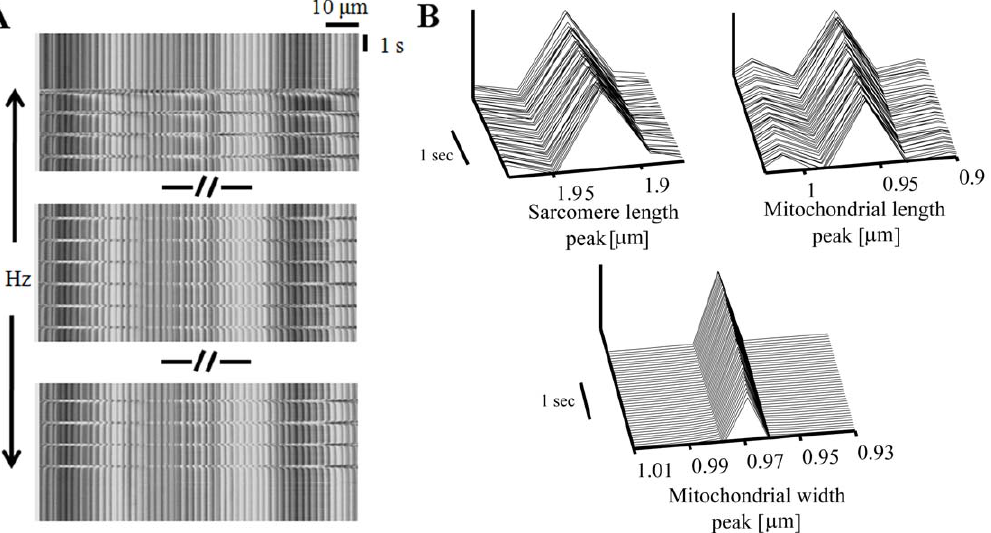
Figure 2. Fourier transform spectra obtained from linescan imaging to determine sarcomere and mitochondrial dimensions. (A) Transmitted optics line-scan image along cardiomyocyte long-axis ( length-x ) during rest and electrical stimulation (1 Hz). (B) Sarcomere length and mitochondrial length and width peaks during quiescent state determined from frequency domain analysis.